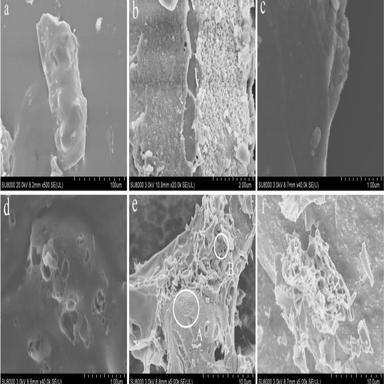
SEM images of (a) integrated RHC, (b) ground RHC, namely PC1, (c) PC2, (d) PC3, (e, f) AC2.